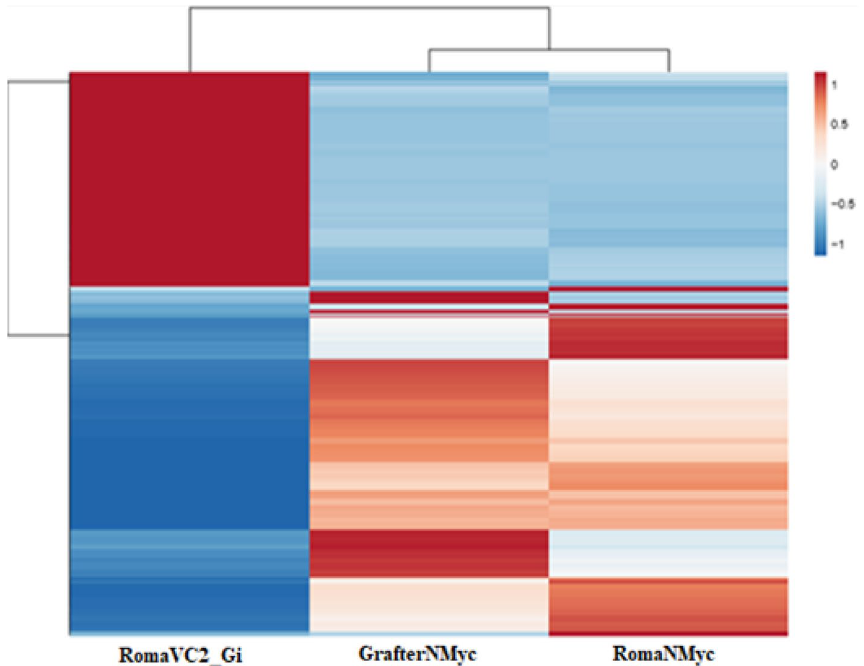
Figure 4. Heatmap to visualize hierarchical clustering of AM symbiosis-specific genes (up- and down- regulated) between AM-inoculated host and non-inoculated host and non-host. This figure represents heatmap for 963 mycorrhization-specific genes obtained by comparative RNA seq analysis of AM-inoculated host (RomaVC2_Gi) with non-inoculated host (RomaNMyc) and non-host (GrafterNMyc) clearly depict a subset of genes that are strongly upregulated (red) and downregulated (blue) in mycorrhized host root (RomaVC2_Gi) when compared with both non- inoculated host (RomaNMyc) as well as non- host (GrafterNMyc).